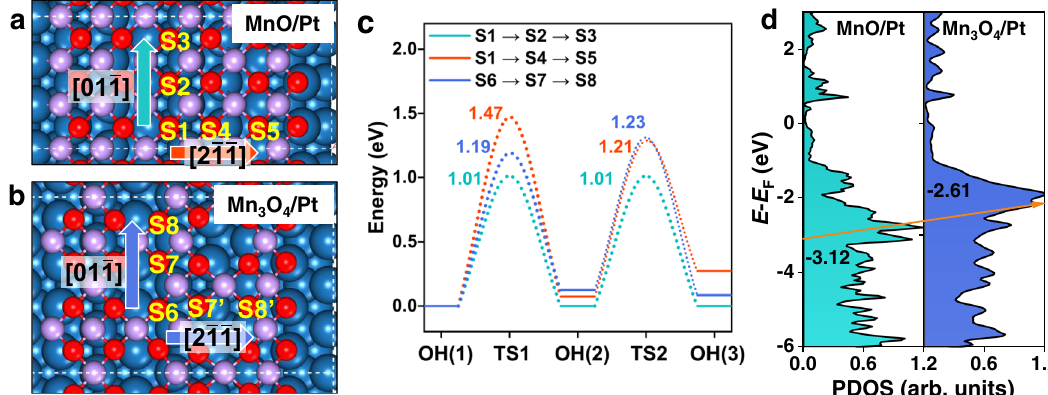
Fig. 5 | Theoretical analysis on difference of hydrogen diffusion over the MnO and Mn 3 O 4 monolayers. Proposed monolayer ( a ) MnO and ( b ) Mn 3 O 4 fi lms sup- portedonPt(111)substrate.H:white;O:red;Mn:lightviolet;Pt:darkblue.Here,the characteristic surface O sites are denoted by yellow symbols and the hydrogen diffusiondirectionsareindicatedbycoloredarrows. c Potentialenergydiagramfor O-Hdiffusionfromsitetositecorrespondingto( a )and( b ).Thezeroenergylevelis